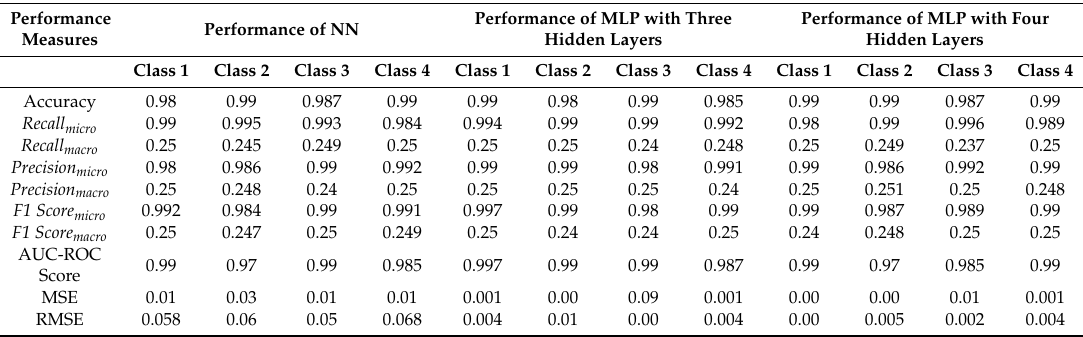
Performance of MLP with Three Hidden Layers